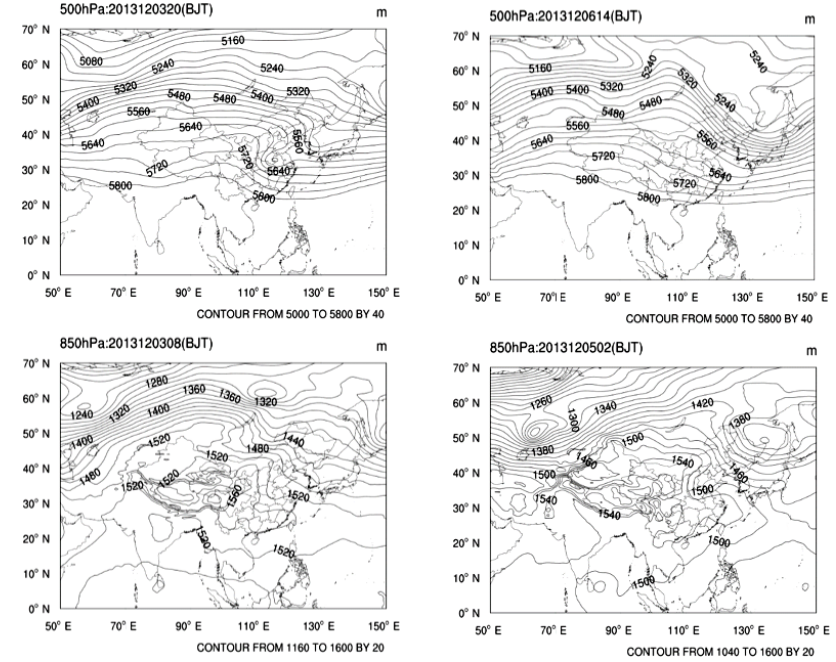
Figure 8. Atmospheric circulation situation at 500 and 850hPa from 3 to 6 December